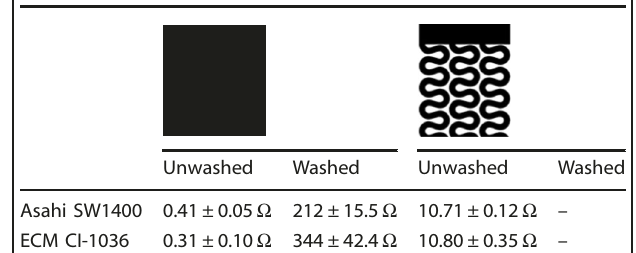
Table 1. SEM-EDS elemental analysis of the surface of washed and unwashed electrodes.